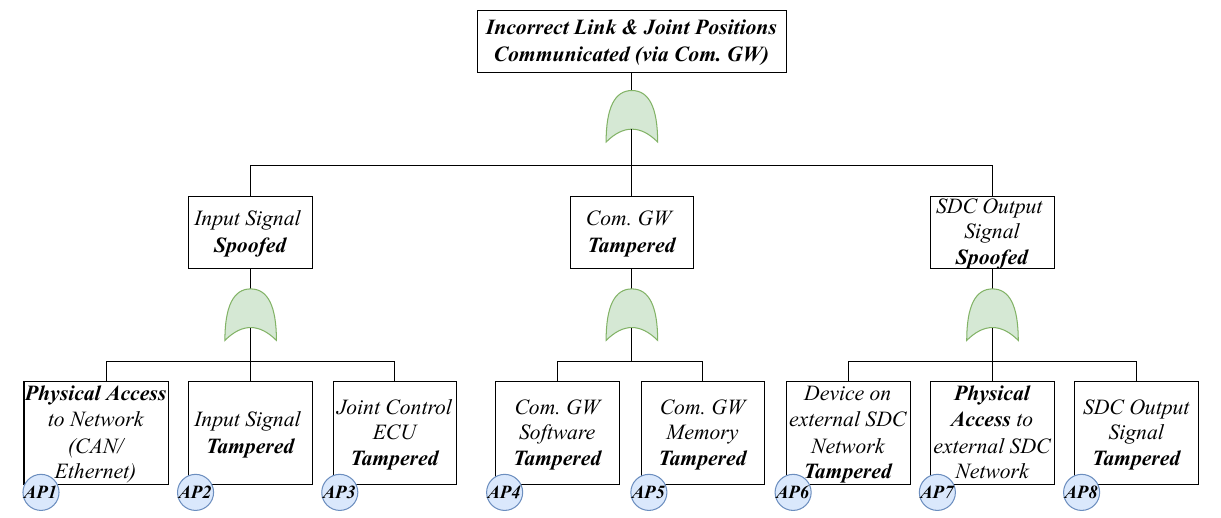
Figure 7. Attack tree for communication of incorrect link and joint positions. If the height of the OR table is incorrectly communicated to a connected device such as an angiography system, serious damage can occur to both systems or even the patient in the case of a collision (Figure 8).